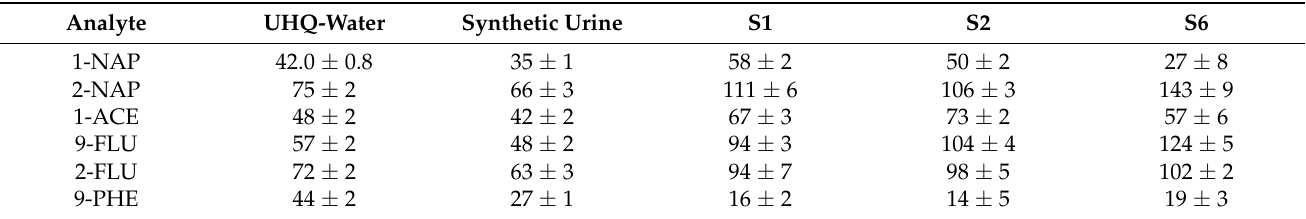
Table 1. Comparison of the slopes found for the linear equations obtained with UHQ-water, synthetic urine, and three urine samples from subjects S1, S2, and